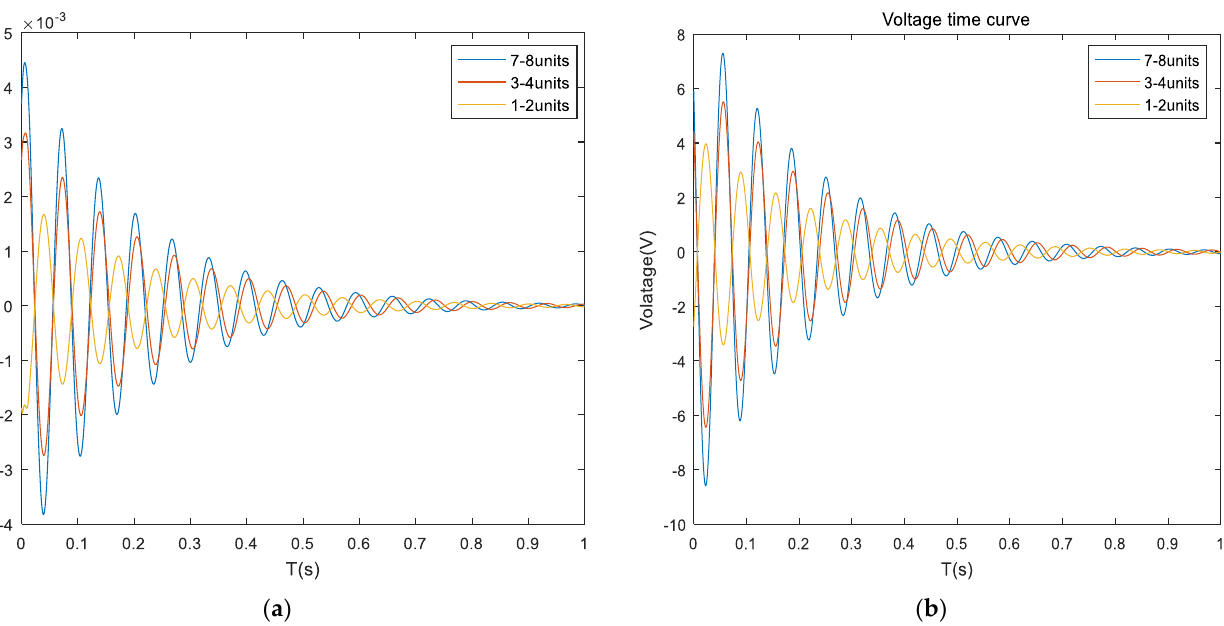
Figure 11. Response diagram of sandwich plates under different covering methods (without applied voltage).